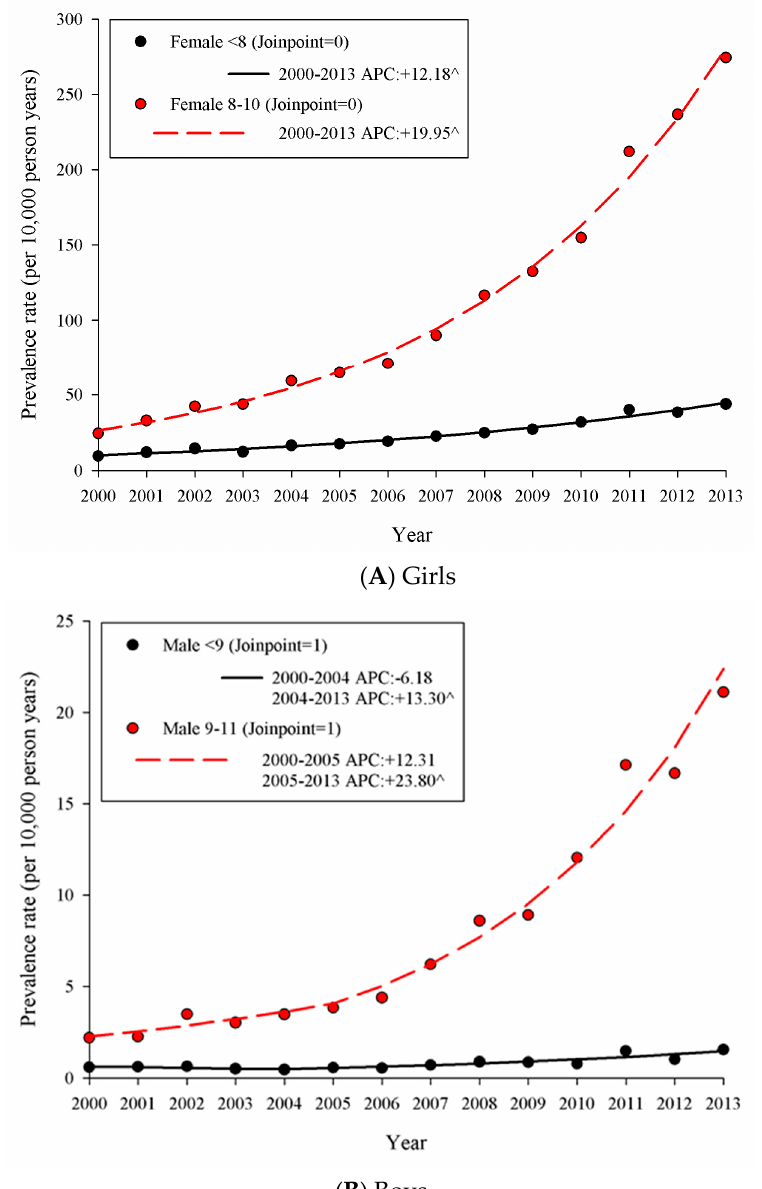
Figure 1. The trend of the prevalence rate of precocious puberty in ( A ) girls and ( B ) boys from 2000 to 2013; the symbol “^” indicates where the annual percent change (APC) was significantly different from zero.